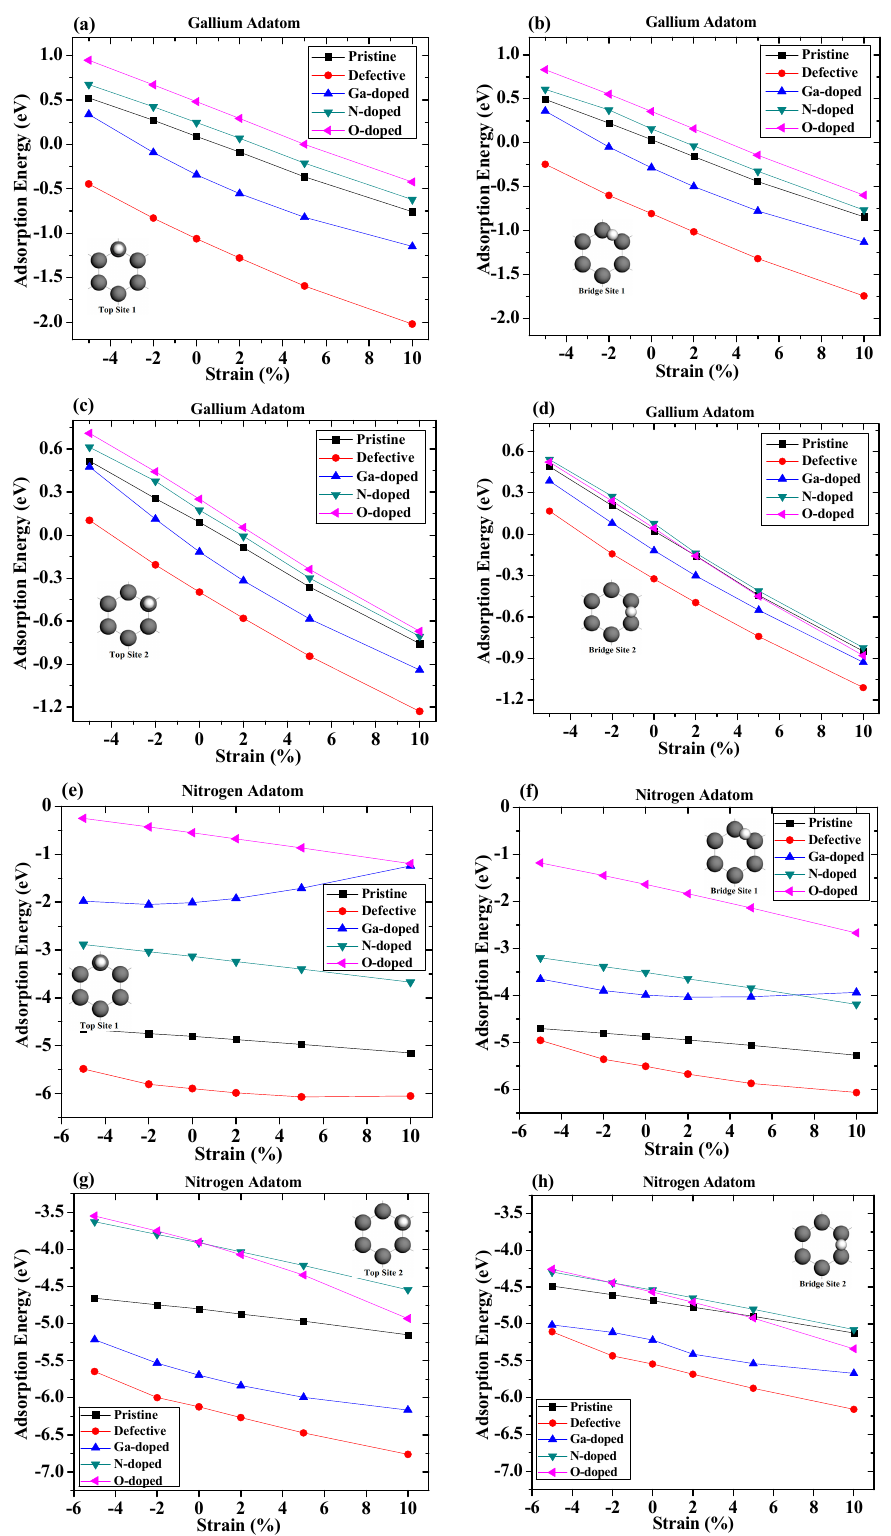
Figure 6. The dependence of adsorption energy for gallium adatom adsorption on graphene at ( a ) Top Site 1; ( b ) Bridge Site 1; ( c ) Top Site 2; ( d ) Bridge Site 2; and nitrogen adatom adsorption on graphene at ( e ) Top Site 1; ( f ) Bridge Site 1; ( g ) Top Site 2; ( h ) Bridge Site 2e on the applied compressive and tensile strain, respectively.